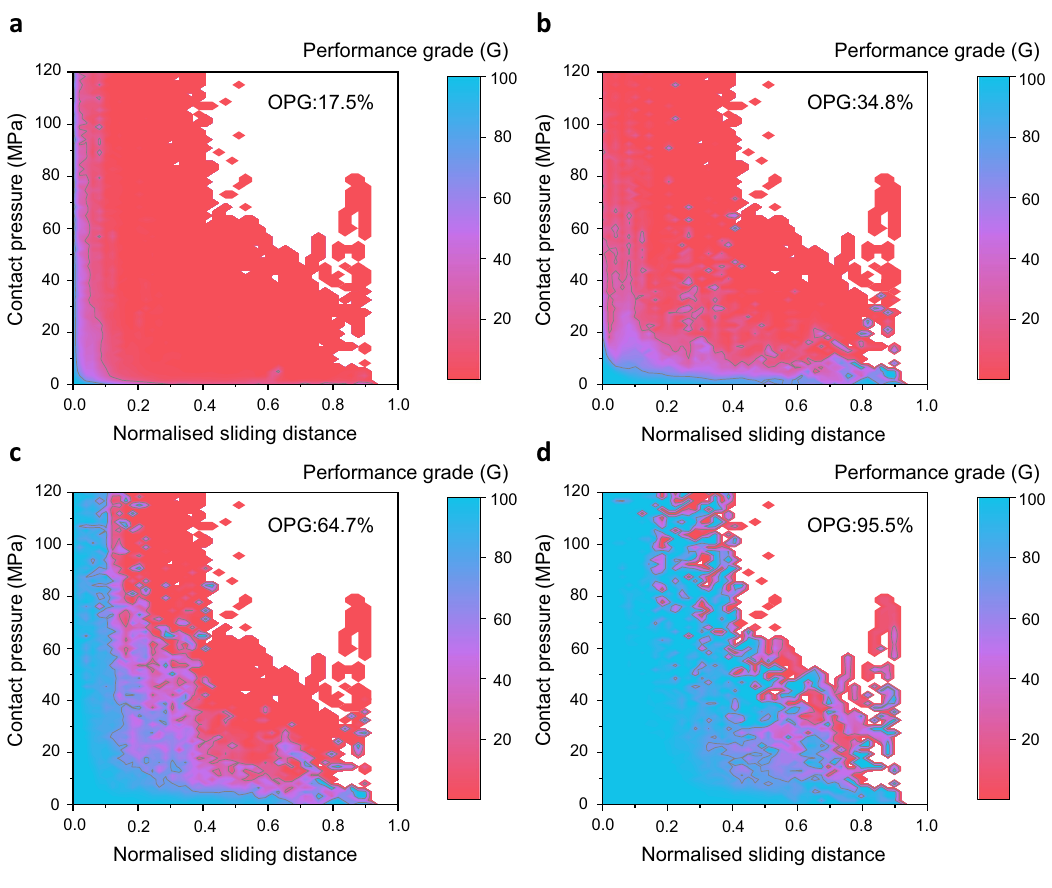
Fig. 3 | Digitally enhanced evaluation of four lubricants applied in the hot stamping process via the lubricant limit diagram (LLD) demonstrated by the